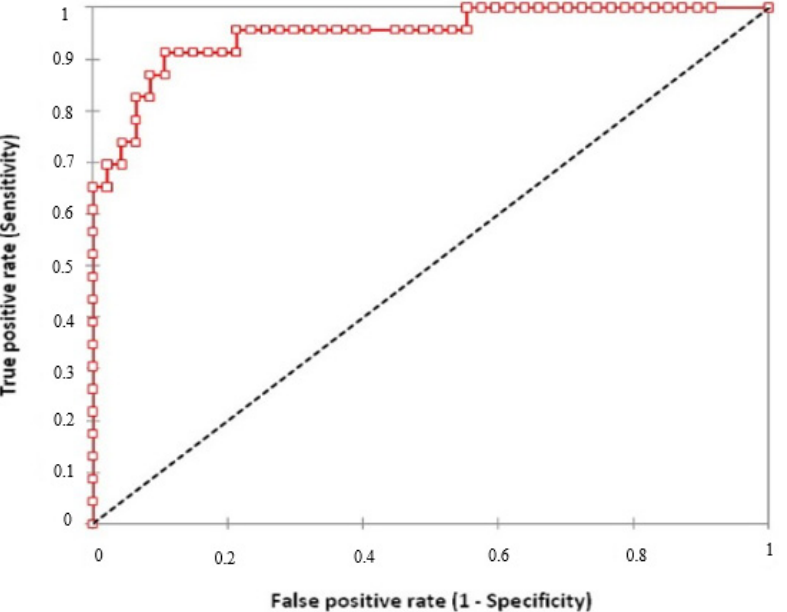
Figure 1. ROC curve analysis for the released plasma inducible protein-10. The cut-off values were determined using QFT-GIT(+) and QFT-GIT( − ) patients with inflammatory rheumatic diseases. The area under curve was 0.950 (95% CI 0.906–0.994). (Red line: stimulated IP-10 levels; Black line: reference).